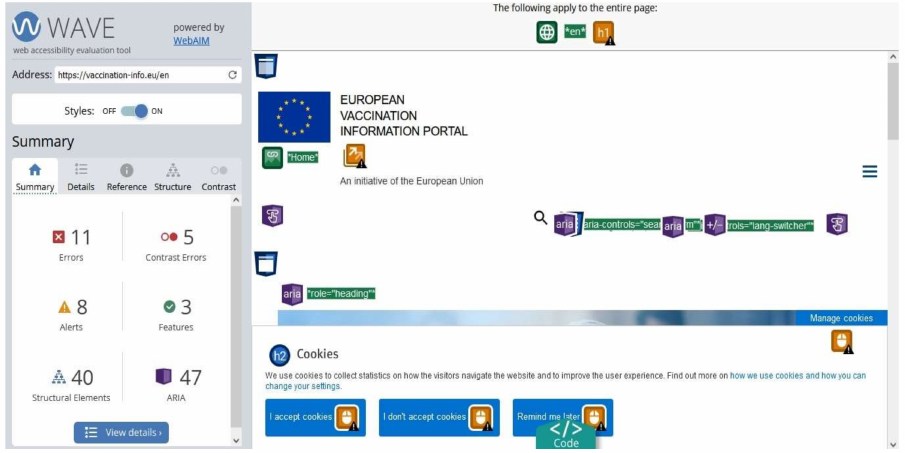
Figure 6. Screenshot of WAVE Web accessibility testing tool (view